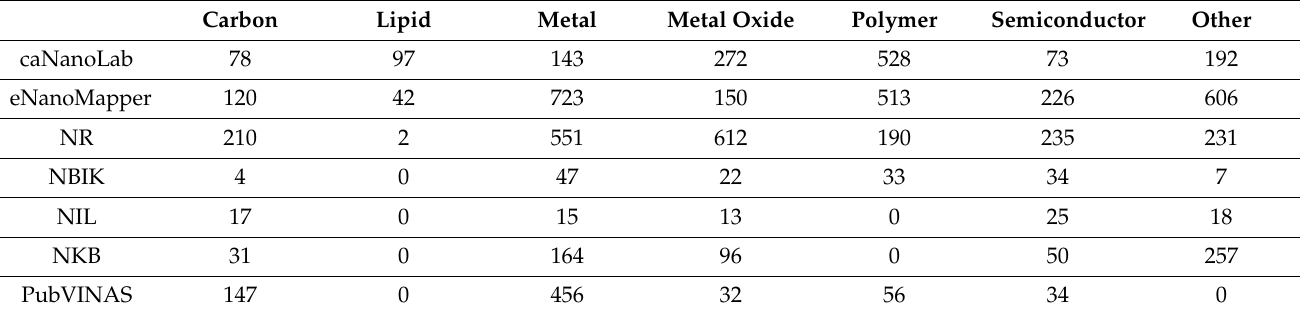
Table 2. Nanomaterials in the seven databases.